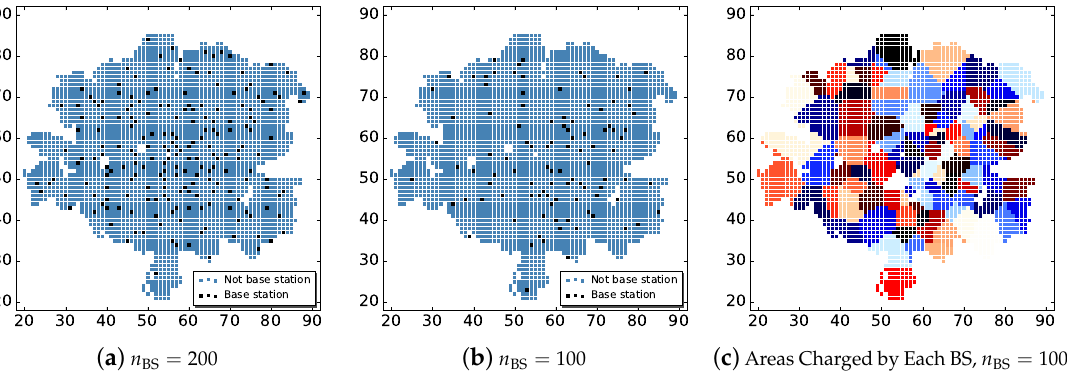
Figure 2. The location distributions of sampled base stations and the areas in charged by them. ( a , b ) shows the sampled base station distributions for n BS = 200 and n BS = 100; ( c ) shows the areas in charged by different base stations for n BS =